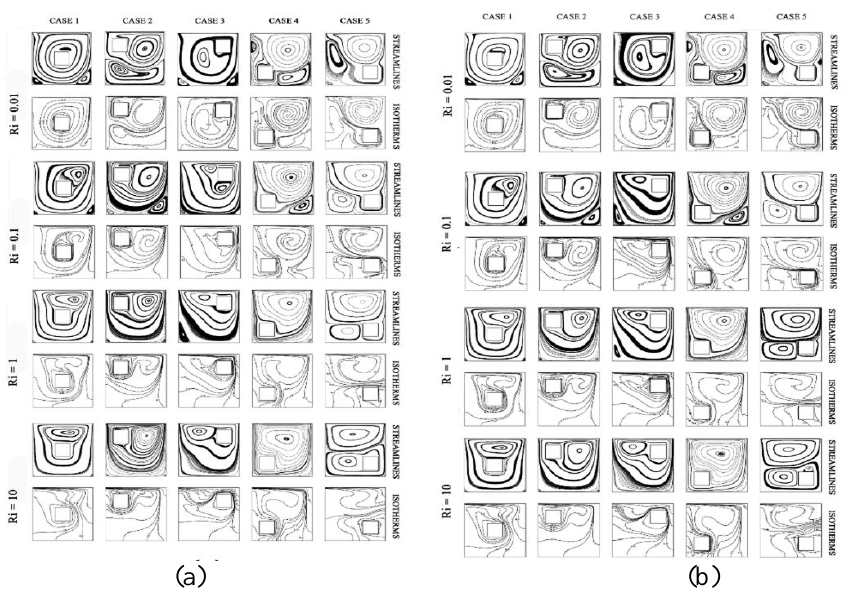
Figure 5. Streamlines and isotherms for various geometrical cases at Ø = 0 %